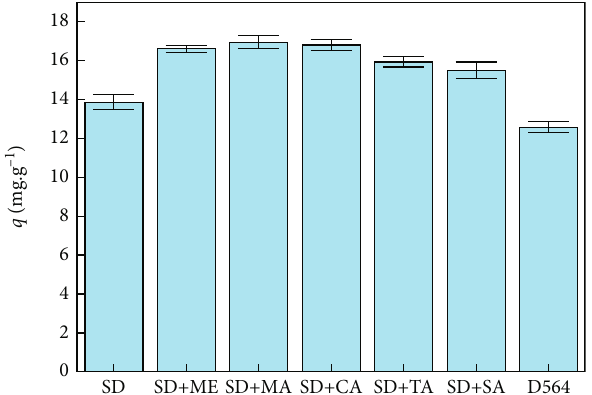
Figure 2: Comparison of boron adsorption capacity on SD,